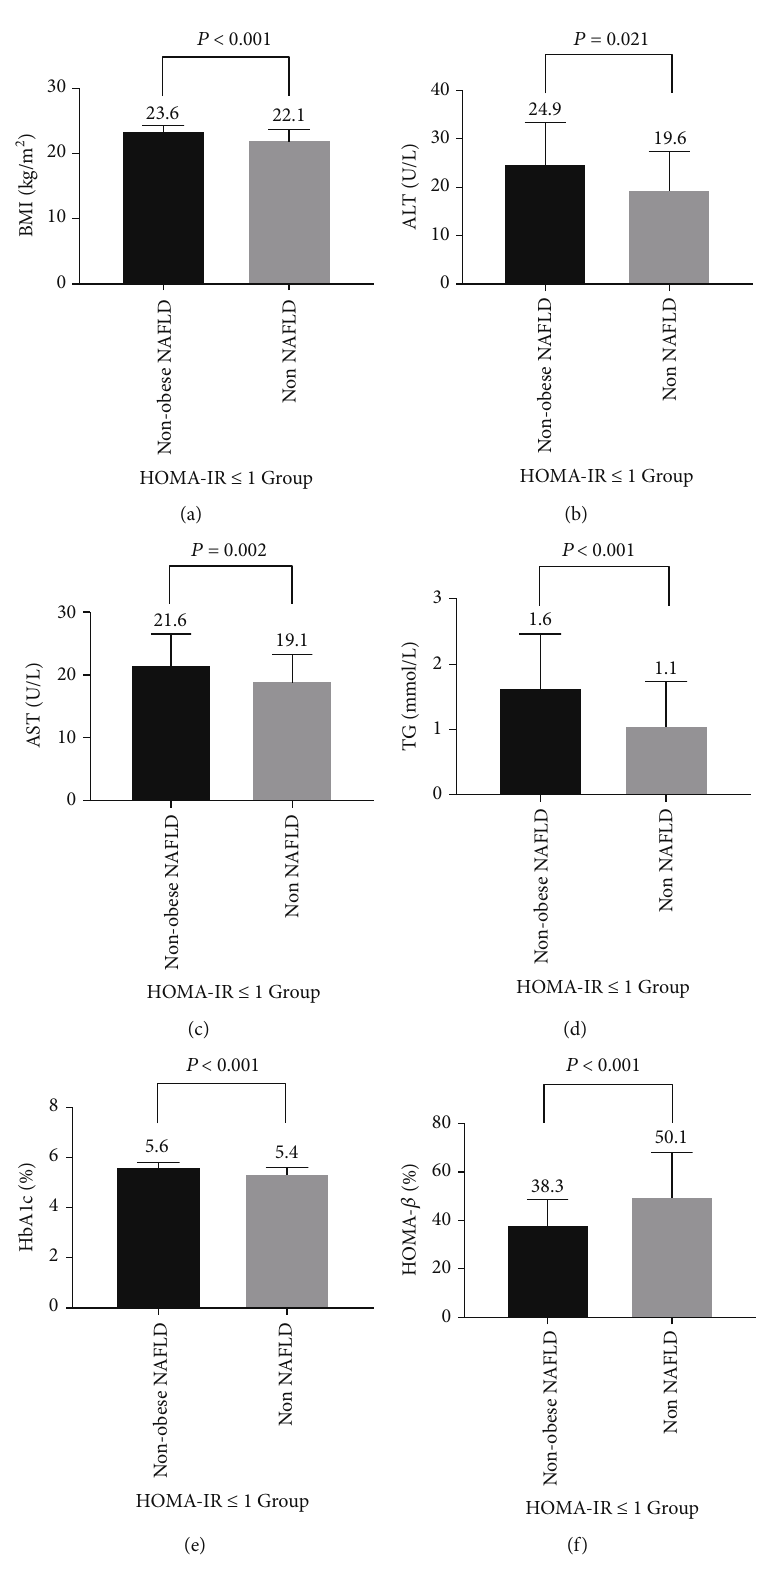
Figure 2: HOMA − IR ≤ 1 group. The characteristics of the participants of nonobese NAFLD and non-NAFLD. (a) BMI; (b) ALT; (c) AST; (d) TG; (e) HbA1c; (f) HOMA- β